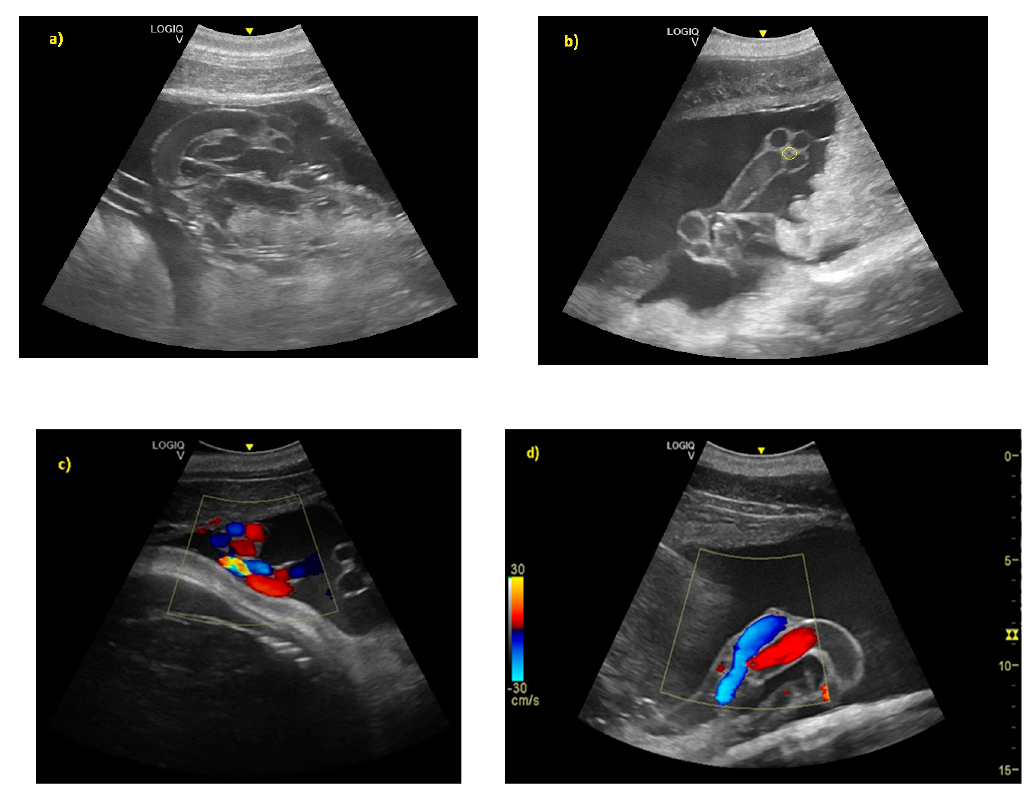
Figure 5. ( a ) From day 119 ± 6 of gestation, the umbilical cord was clear as a hyper-echoic cordoniform structure. ( b ) The small hypo-echoic central cavity is the urachus, shown by the yellow circle. ( c ) Color Doppler demonstrating flow within the umbilical vasculature: ( d ) the umbilical veins (in blue), and the umbilical arteries (in red).